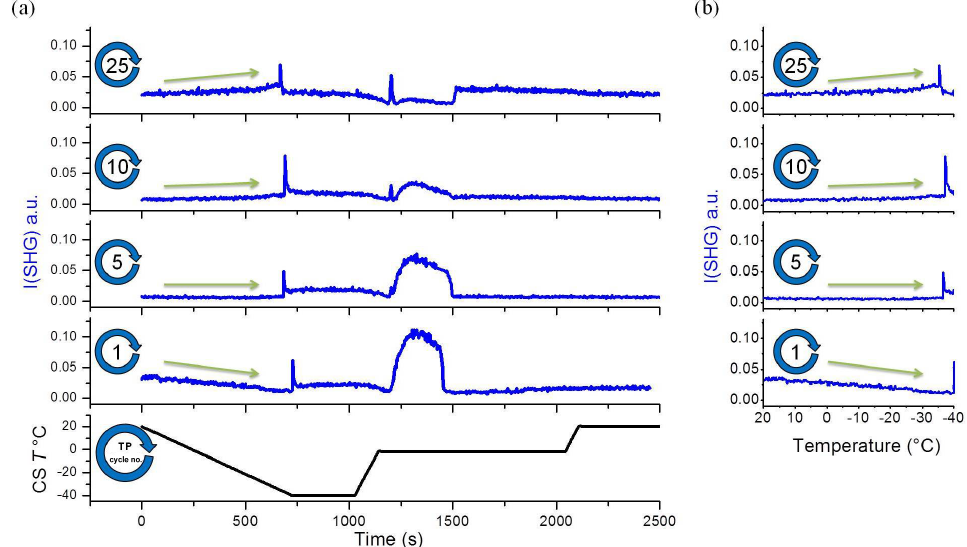
Figure 3. A selection from the set of plots shown in Fig. 2. (a) Temperature and SHG signal as a function of time. (b) SHG liquid signal as a function of temperature during cooling. This set of subplots shows clear change in the I (SHG) temperature dependence during the TP iteration. CS T is cold-stage